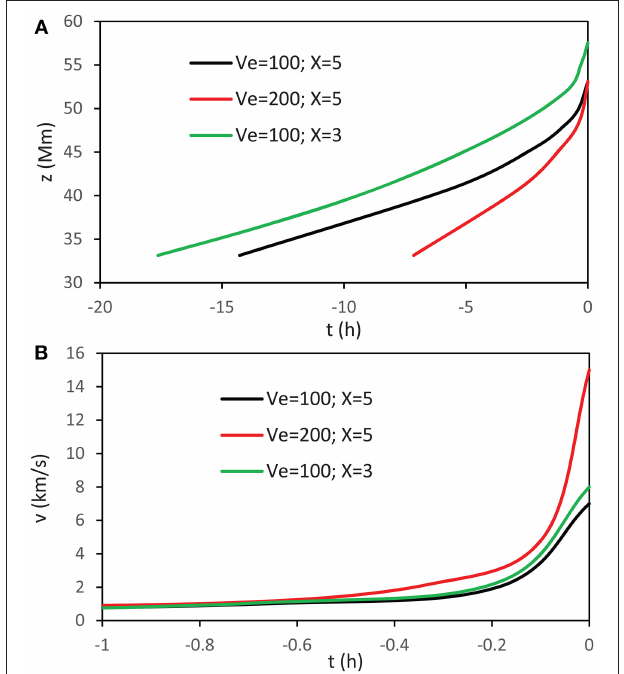
FIGURE 7 | Evolution of the flux rope caused by emerging flux, until the moment of the loss of equilibrium ( t = 0): (A) height–time; (B) velocity–time. The black and red curves are calculated for the initial C L1 =11ms − 2 , whereas green curve represents C L1 =12ms − 2 . To better resolve the evolution of the rising speed, in the lower panel only the 1-h interval before the eruption is presented.